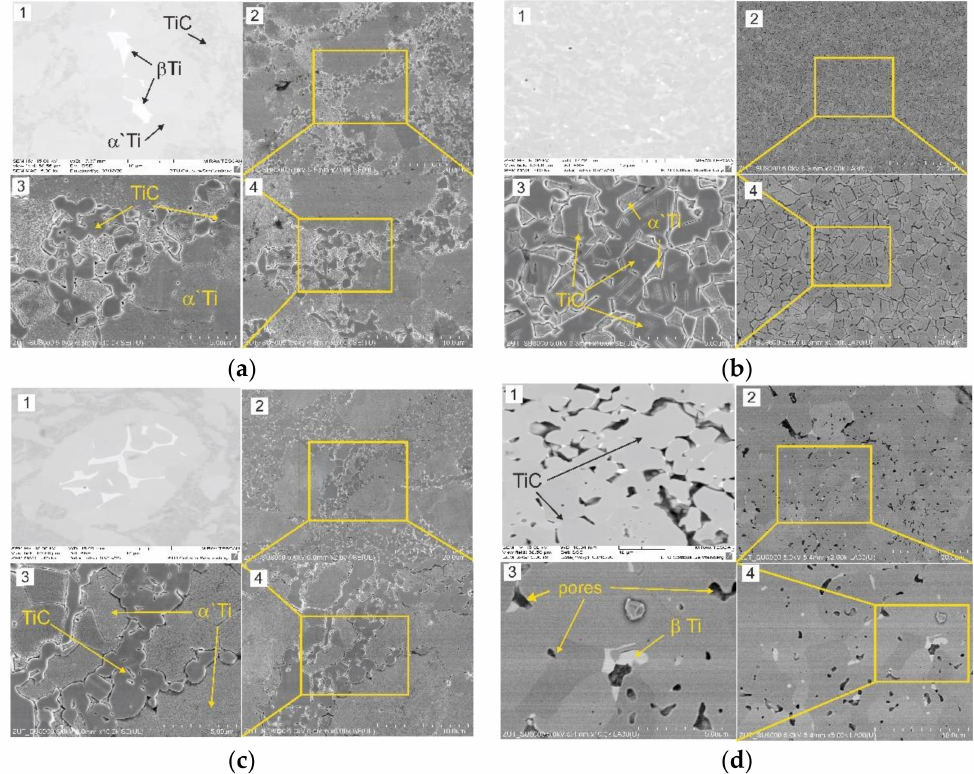
Figure 7. SEM micrographs of the microstructure of the titanium composites: ( a ) Ti + 10 wt %(Ti,Mo)C; ( b ) Ti + 10 wt %(Ti,Mo)C/C; ( c ) Ti + 20 wt %(Ti,Mo)C; ( d ) Ti + 20 wt %(Ti,Mo)C/C. (1) BSE micrograph of a polished specimen, (2–4) SEM micrographs of the composite etched in Fuss reagent by immersion for 30 s.